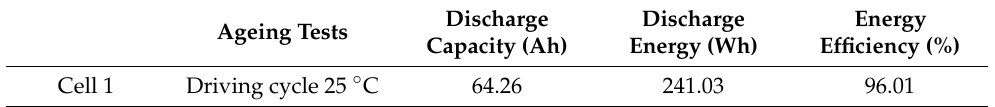
Table 9. Main parameters of cells at the